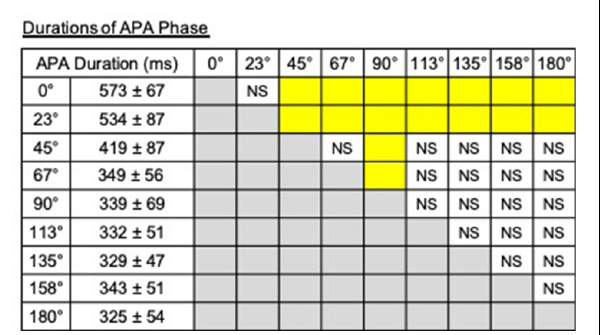
FIGURE 8 | Durations of the APA phase and the results of post hoc tests. The pairs shown in the columns colored in yellow show significant differences ( P < 0.05). NS,